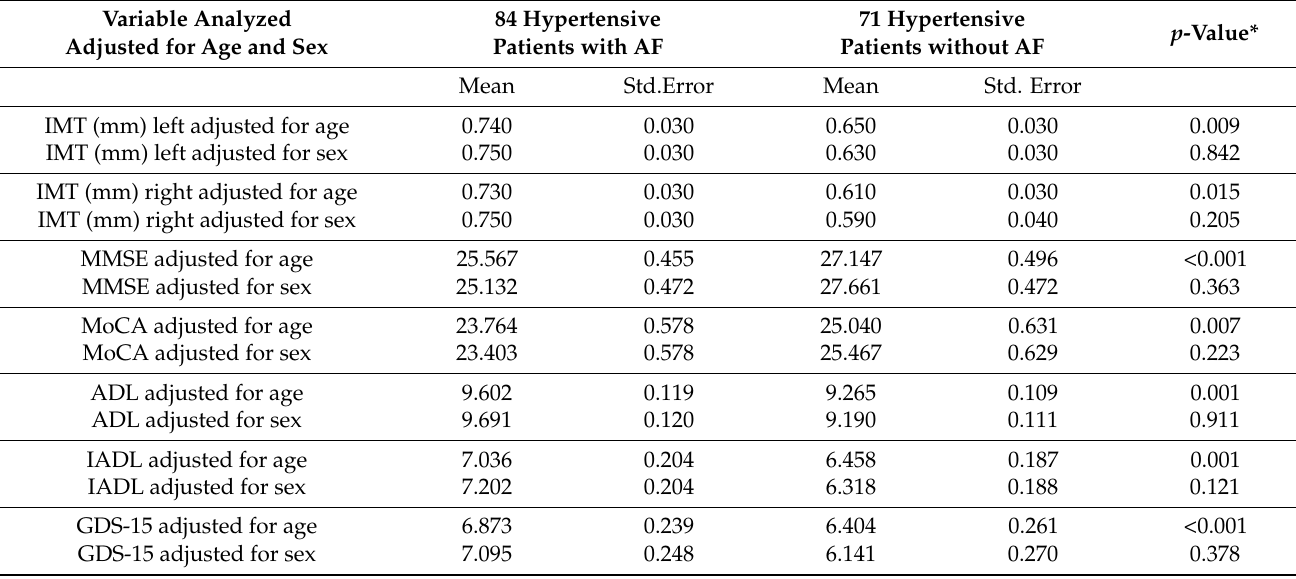
Table 7. IMT and screening tools for cognitive impairment, daily activity, and depression scalesin both groups of patients adjusted for age and